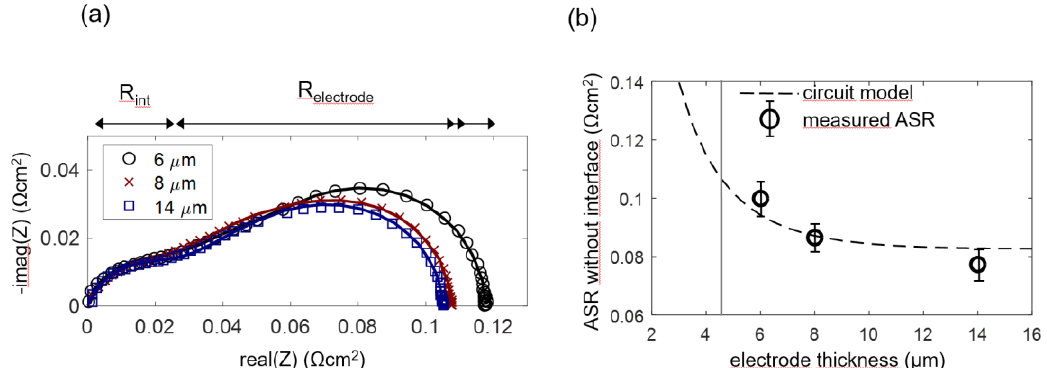
Figure 11. ( a ) Measured (symbols) and fitted (lines) impedance spectra of Ni / GDC anodes (6, 8 and 14-µm-thick) at 750 °C in 45 mbar H 2 + 25 mbar H 2 O without balance gas. For comparability, the electrolyte resistance was subtracted. ( b ) Plot of measured ASR after subtracting the interfacial resistance compared to the circuit model. The grey vertical line represents the averaged electrochemically active thickness λ , and the dashed line represents ASR as a function of the thickness, according to the circuit model with averaged fitting parameters.